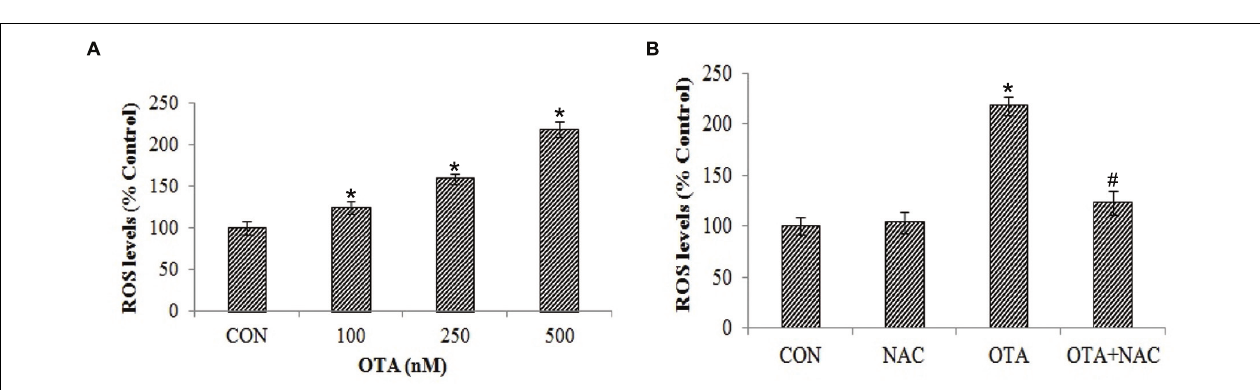
FIGURE 2 | Effect of OTA on reactive oxygen species (ROS) production in Neuro-2a and its scavenging by NAC. (A) Neuro-2a cells were treated with various concentrations of OTA (100–500 nM) for 24 h. ROS levels were monitored by using DCFH-DA (B) . Neuro-2a cells were pretreated with NAC (1 mM) for 24 h followed by OTA (500 nM) treatment for 24 h and intracellular ROS was quantified by using DCFH-DA. The data represented as mean ± SEM of three independent experiments. ∗ p < 0.05 versus respective control group and # p < 0.05 versus respective OTA treated